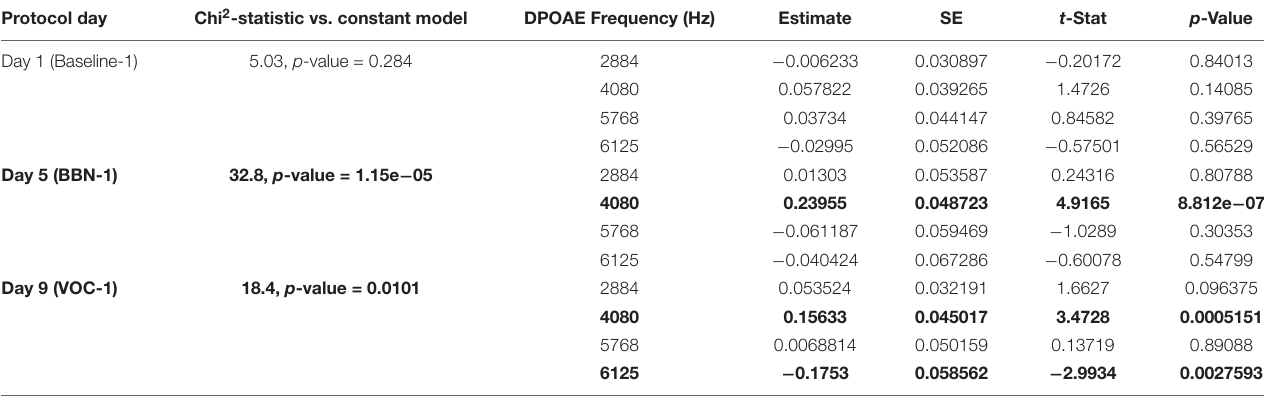
TABLE 1 | The generalized linear models evaluating the association between MOC reflex strength (DPOAE CAS-induced changes) and behavioral performance for early responses ( < 3 s). Protocol day Chi 2 -statistic vs. constant